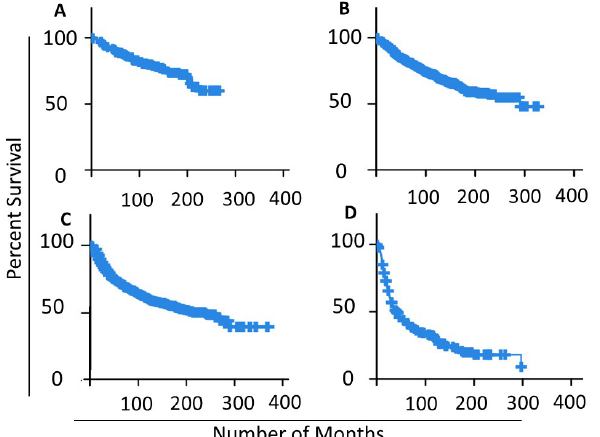
Figure 6. Kaplan–Meier curve for different NPI classes in the studied samples: ( A ) NPI Level I samples; ( B ) NPI Level II samples; ( C ) NPI Level III samples; ( D ) NPI Level IV